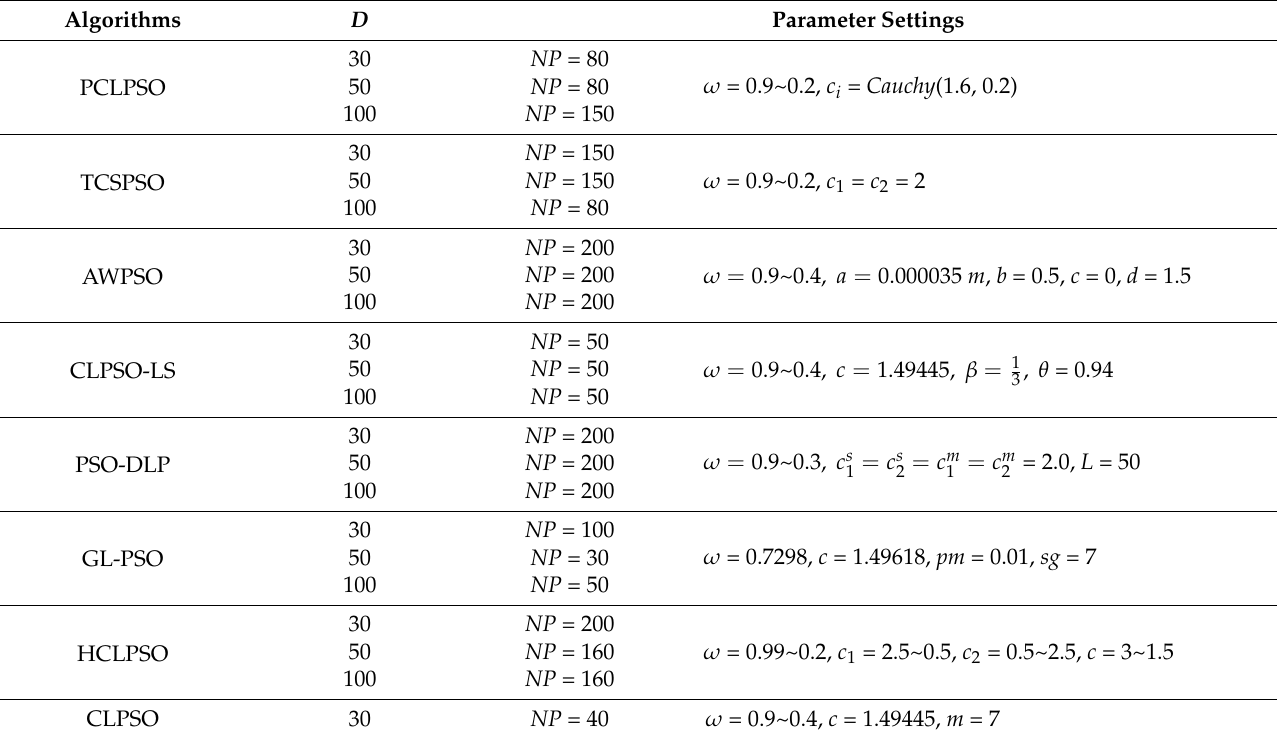
Table 2. Parameter settings of PCLPSO and the seven compared PSO